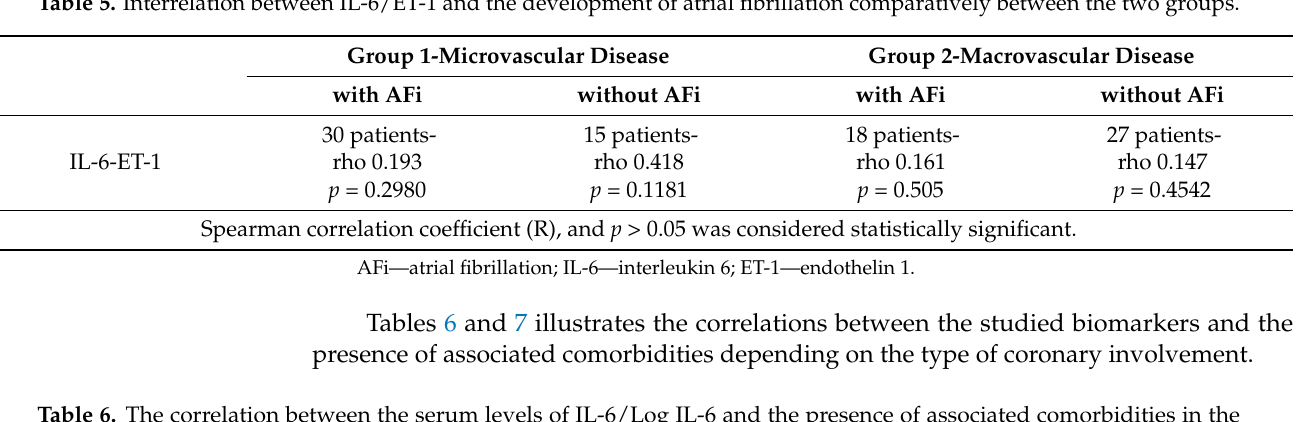
Table 5. Interrelation between IL-6/ET-1 and the development of atrial fibrillation comparatively between the two groups.